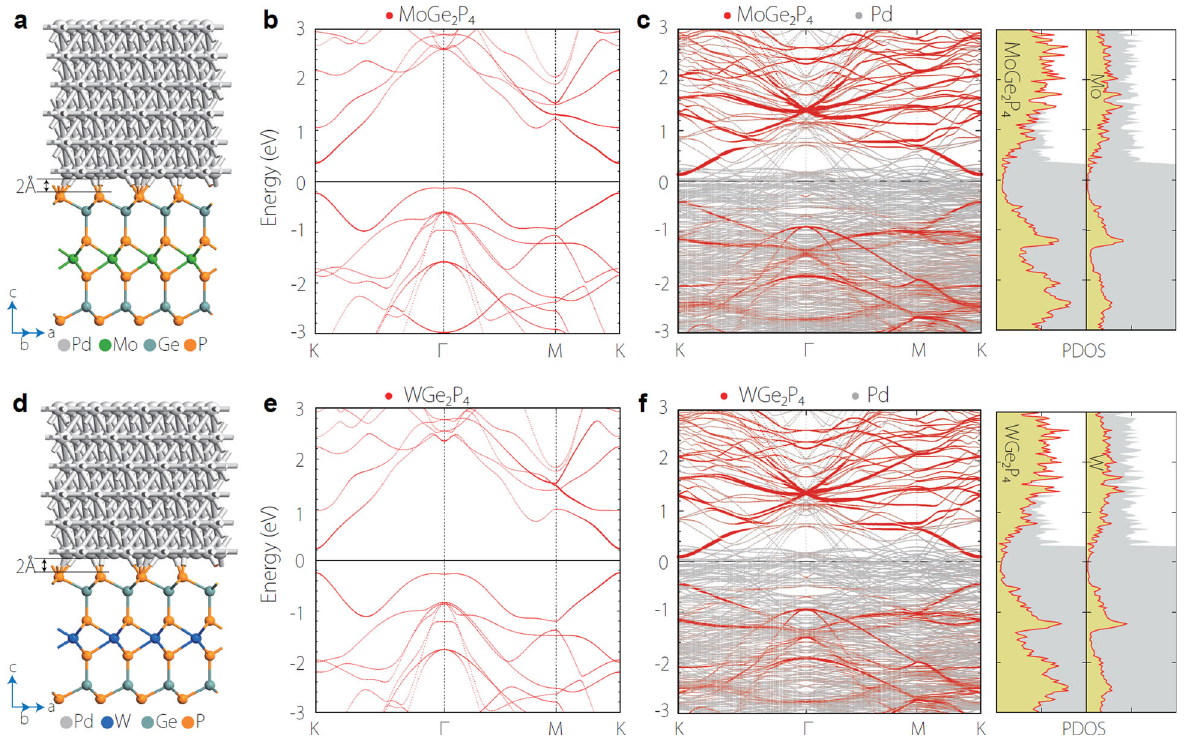
Fig. 6 Close contact simulations of Pd/MoGe 2 P 4 and Pd/WGe 2 P 4 with an interlayer distance of 2 Å . a the structure of Pd/MoGe 2 Si 4 , b electronic band structure of MoGe 2 P 4 monolayer, c the projected electronic band structure and the partial density of states of Pd/MoGe 2 Si 4 . d – f same as a – c , respectively, for Pd/WGe 2 P 4